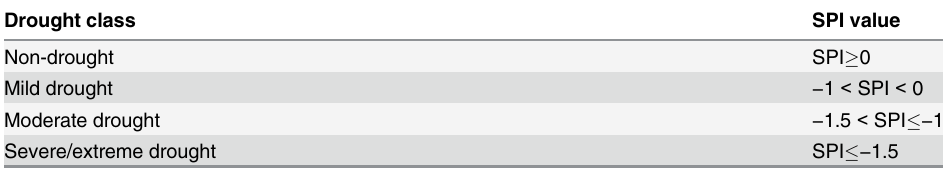
Table 2. Drought classification of